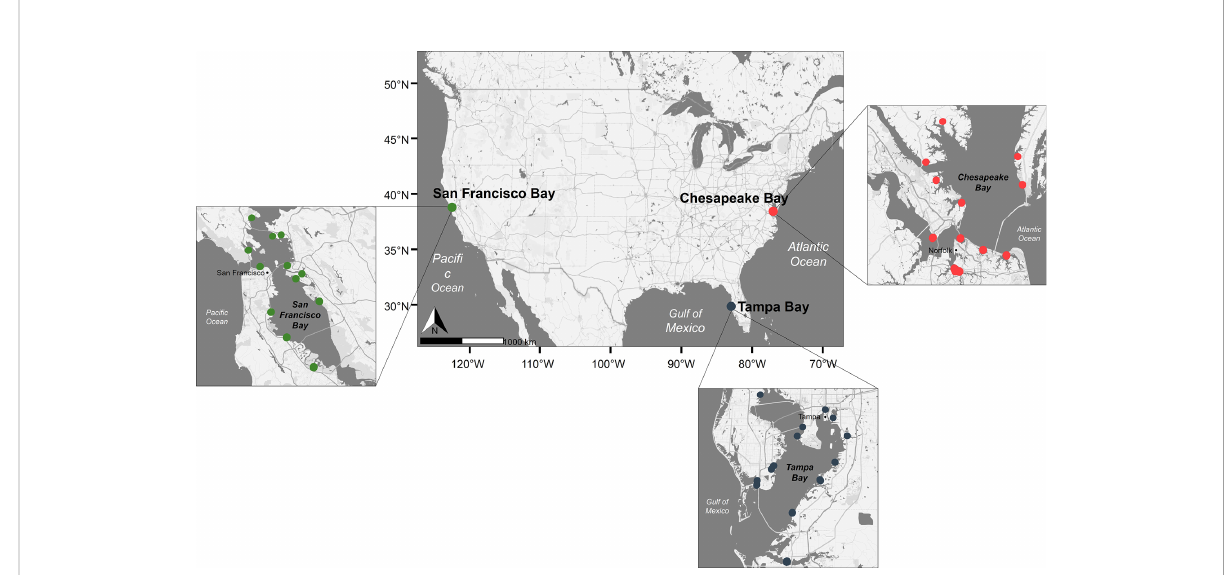
FIGURE 1 Map of panel deployment sites across periods 1 and 2. Colors indicate sites within each bay (red, Chesapeake Bay; green, San Francisco Bay; blue, Tampa